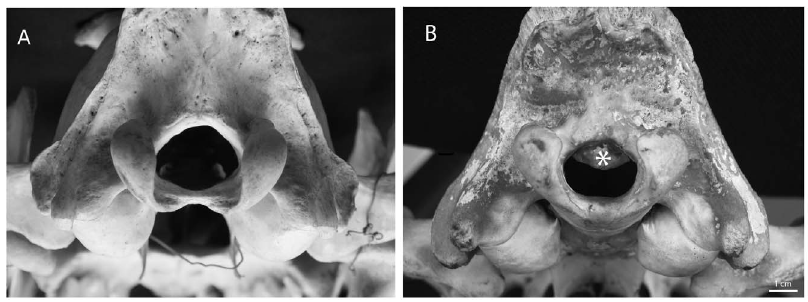
Figure 2. Two captive lion skull specimens. A – A skull of an adult lion with a normal opening of the foramen magnum. B - Abnormal bone growth protruding down from the roof of the foramen magnum (asterisk) in a young adult lion. (Figure 2A courtesy of Mr. Tom Kouris).